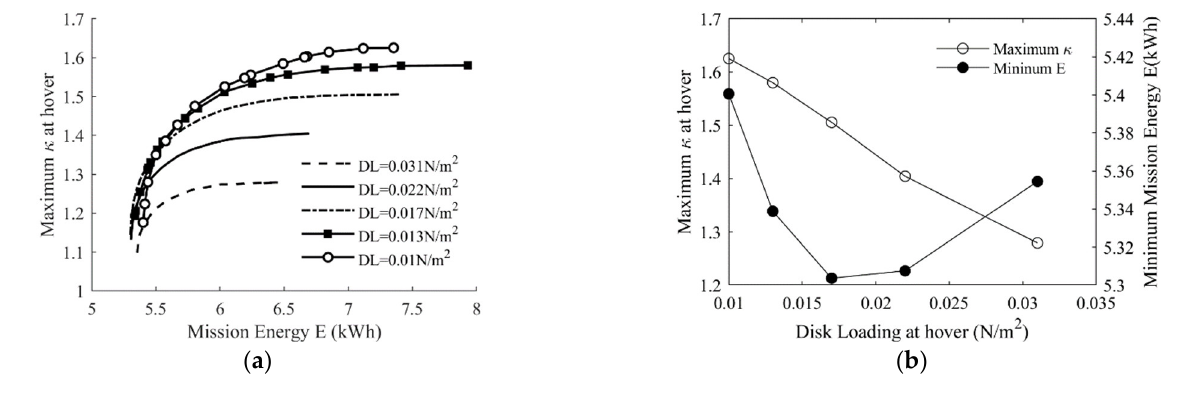
Figure 27. Optimization results with different hover disk loading for an FPP. ( a ) Pareto fronts; ( b ) extreme values of two objectives.